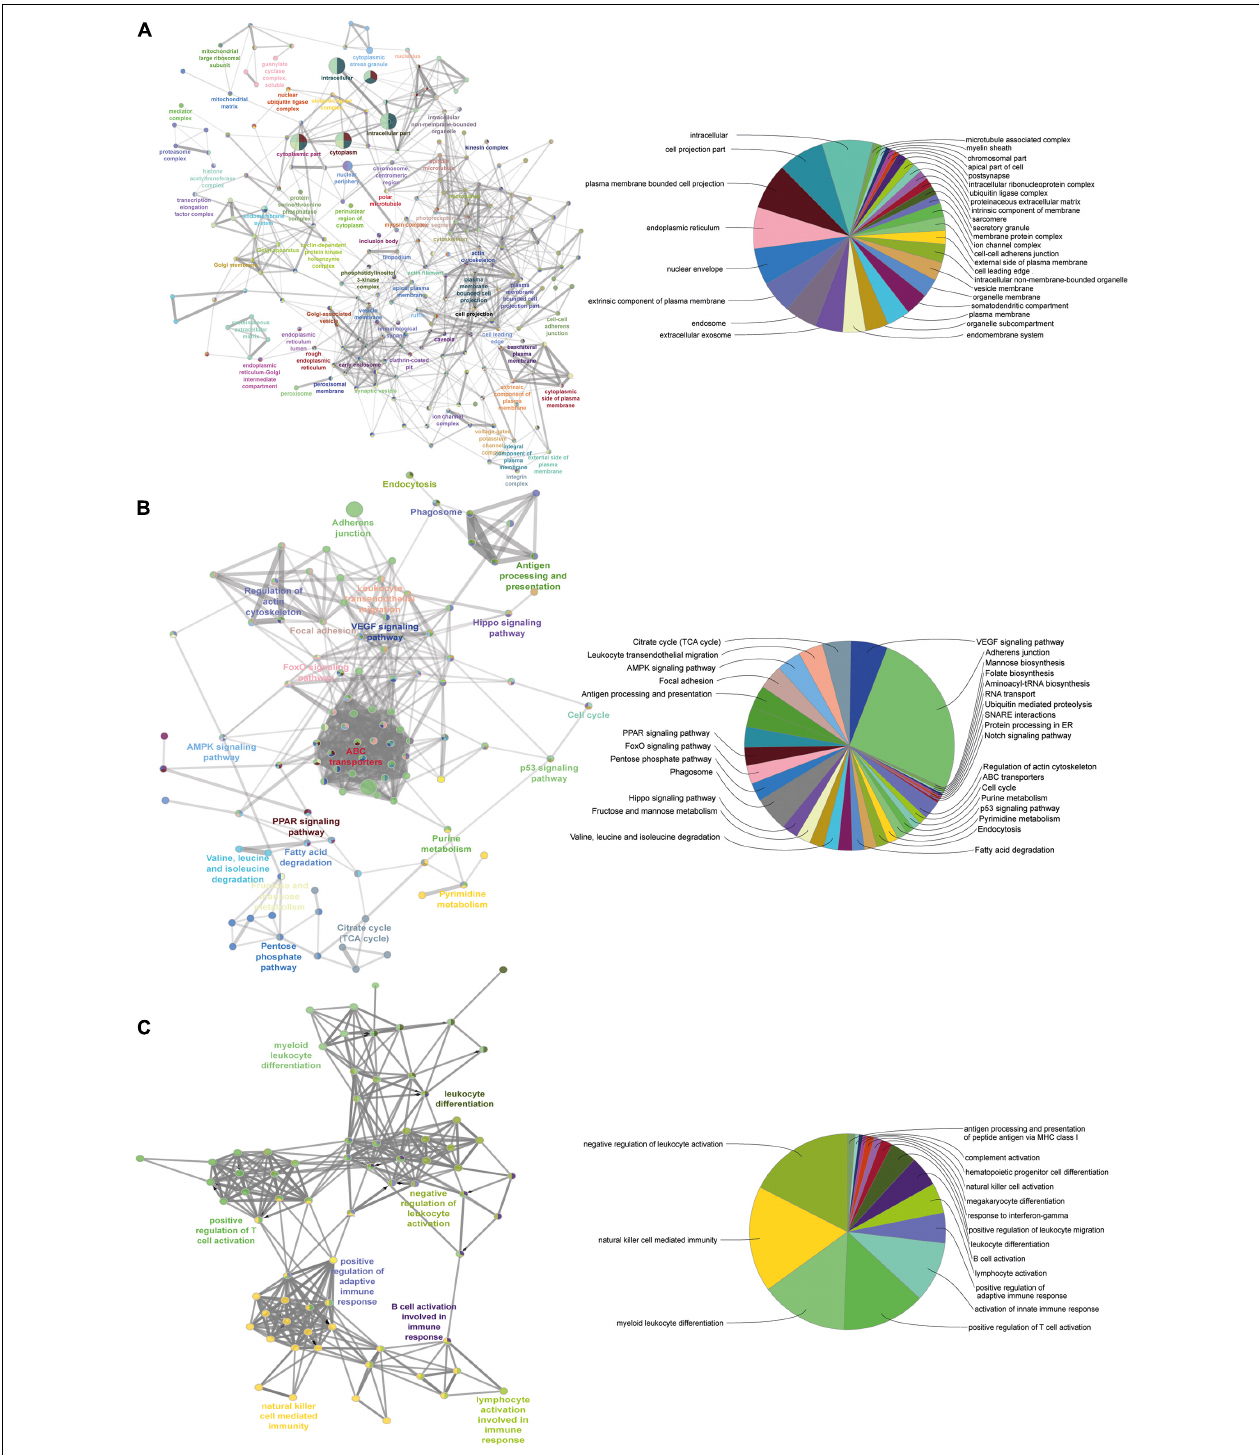
FIGURE 6 | Pathway–pathway interaction analysis. A functionally grouped network of enriched categories was generated for the target genes. GO terms are represented as nodes, and the node size represents the term enrichment significance. Functionally related groups partially overlap. The node pie charts represent the molecular function, immune system processes, reactome analysis of targets. Only the most important term in the group was labeled. (A) Representative molecular function interactions among targets. (B) Representative reactome analysis interactions among predicted targets. (C) Representative immune system processes interactions among